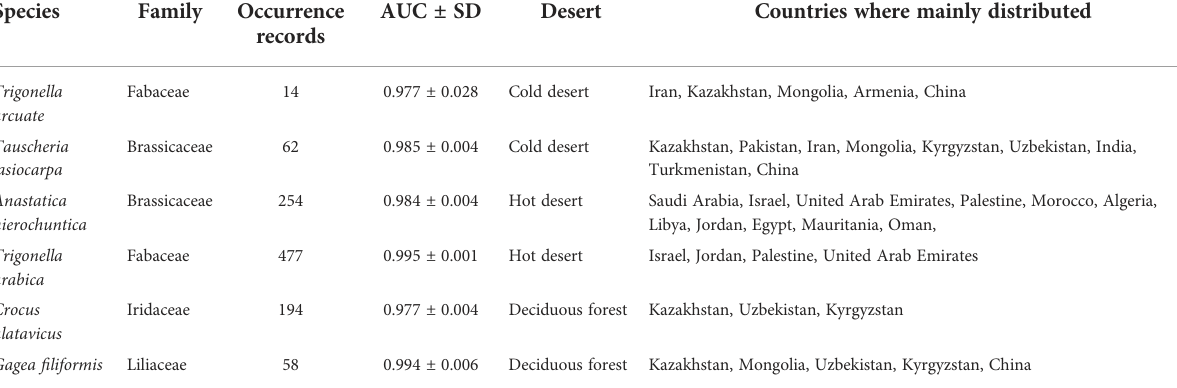
TABLE 3 Species distribution and models ’ area under the receiver operating curve (AUC) of six ephemeral plants.